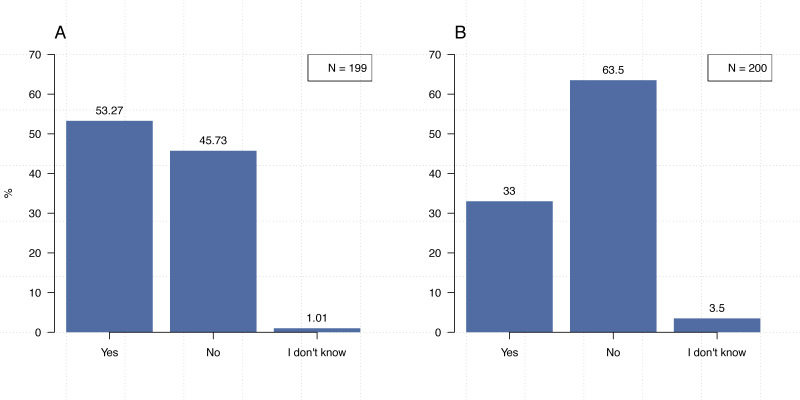
Consistency of programming languages within research groups.(A) Do you write code collaboratively? (B) Does everyone in your lab or research group write code using the same programming language(s)?